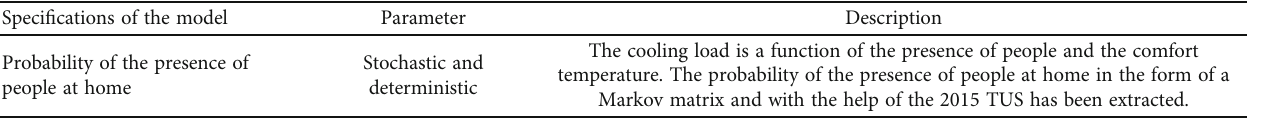
Table 3: Behavioral parameters of the model.